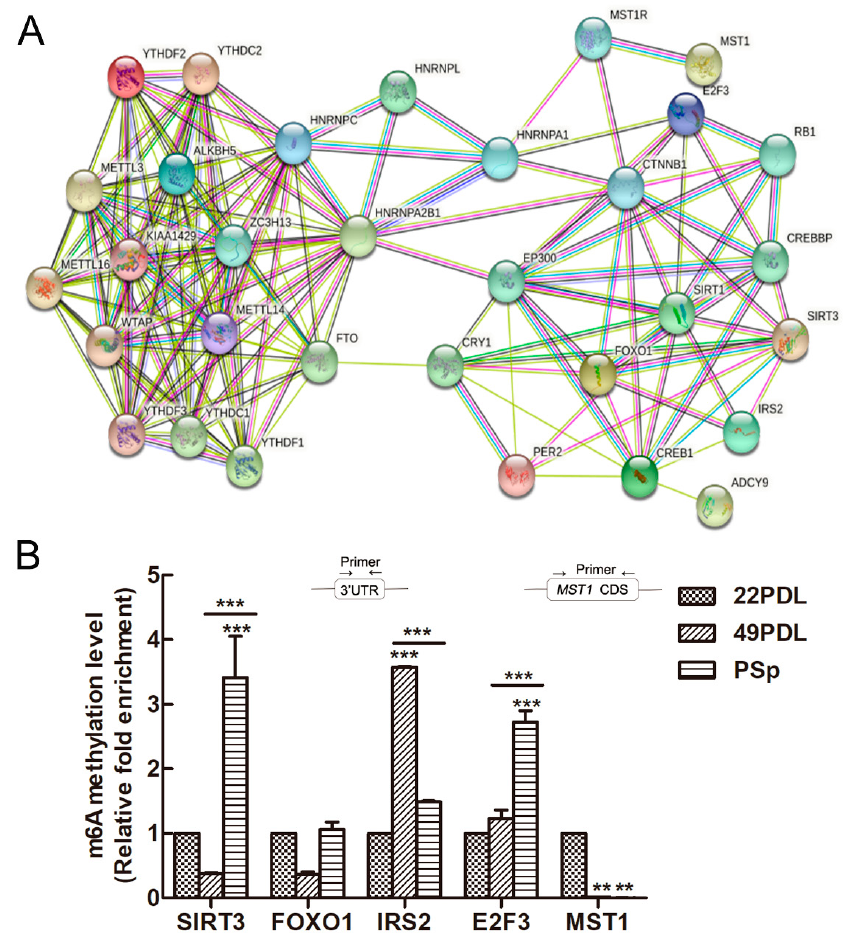
Figure 6. The PPI network and the m6A methylation of candidate genes related to senescence. ( A ) The PPI network included the regulation of m6A RNA-related enzymes and senescence-related proteins. ( B ) Methylation levels in specific regions of aging-related genes detected by MeRIP-qPCR. The 22PDL group was set as 1 and the methylation level of the other group was relative to the 22PDL group. The data are presented as the mean ± SEM ( n = 3). Compared with the 22PDL or 49PDL group, ** p < 0.01, or *** p < 0.001.